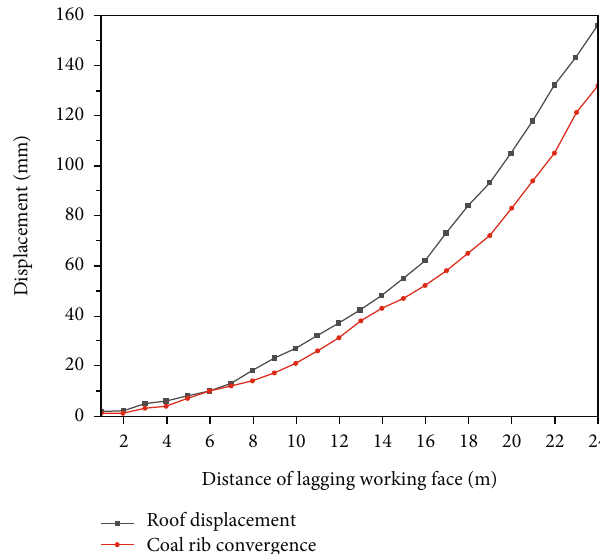
Figure 17: Deformation of surrounding rock of